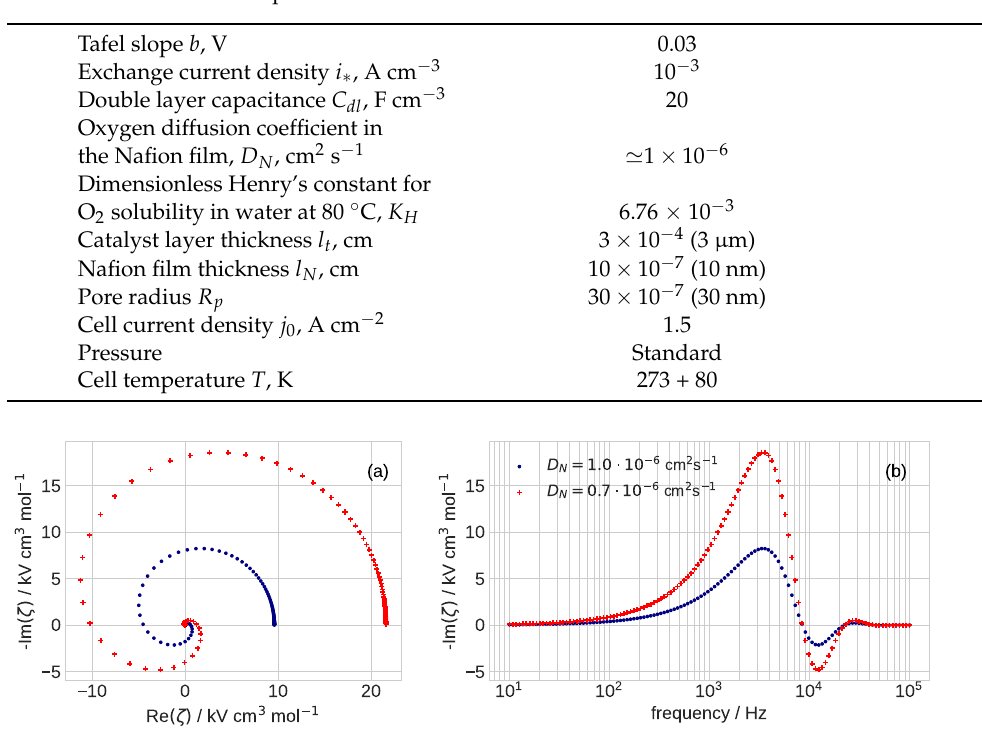
Figure 2. ( a ) The Nyquist spectra and ( b ) the frequency dependence of imaginary part of ζ -impedance, Equation (33), for the indicated values of oxygen diffusion coefficient in the Nafion film D N , cm 2 s − 1 . The other parameters for calculations are listed in Table 1.